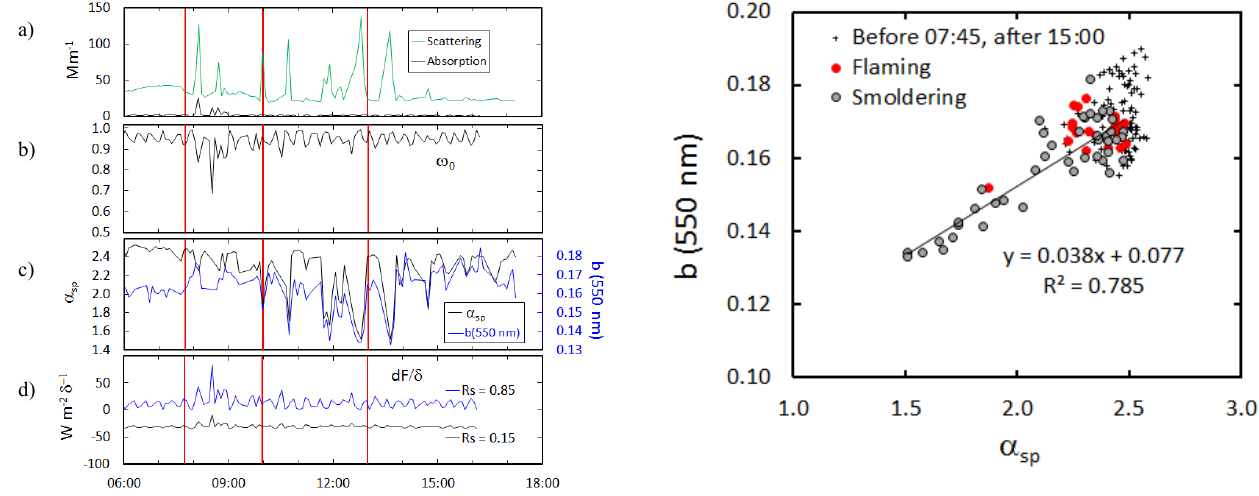
Fig. 11. Optical properties of aerosol observed in the aerosol cot- tage: (a) scattering and absorption coefficients at λ = 550nm; (b) single-scattering albedo at λ = 550nm; (c) Ångström exponent of scattering over 450nm–700nm ( α sp ) and backscatter fraction b at λ = 550nm; (d) intrinsic aerosol forcing efficiency for two surface reflectances ( R s ).